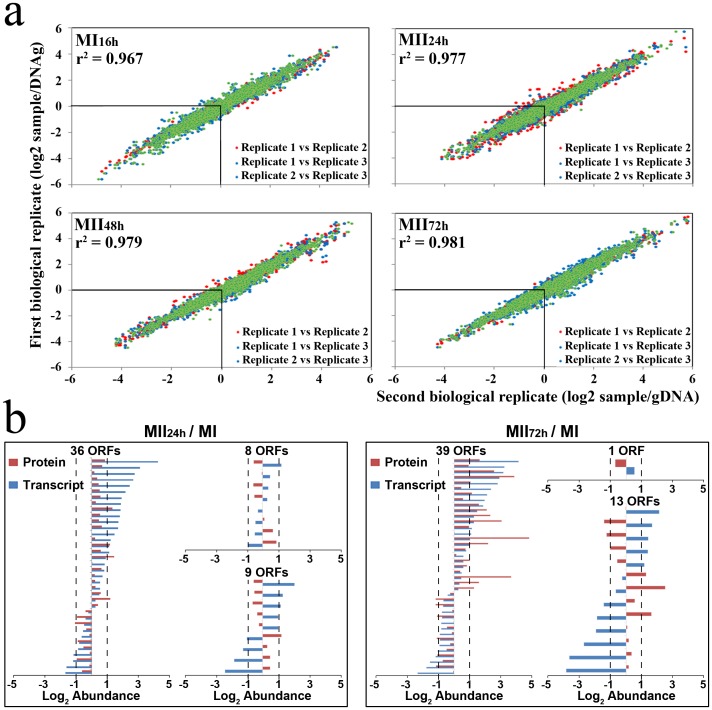
Quantitative transcriptomic data analysis.(a) Correlation of transcription abundance values (log2 ratio against chromosomal DNA) for biological replicates (three biological replicates compared in pairs) significantly quantified (p-value<0.05) (Table S1). Coefficients of regressions among replicates are shown. (b) Abundance values of the ORFs identified by proteomics [5] and transcriptomics (this work). Dashed lines indicate the limit for considering abundance variations as significant (log2 abundances greater than ±1).